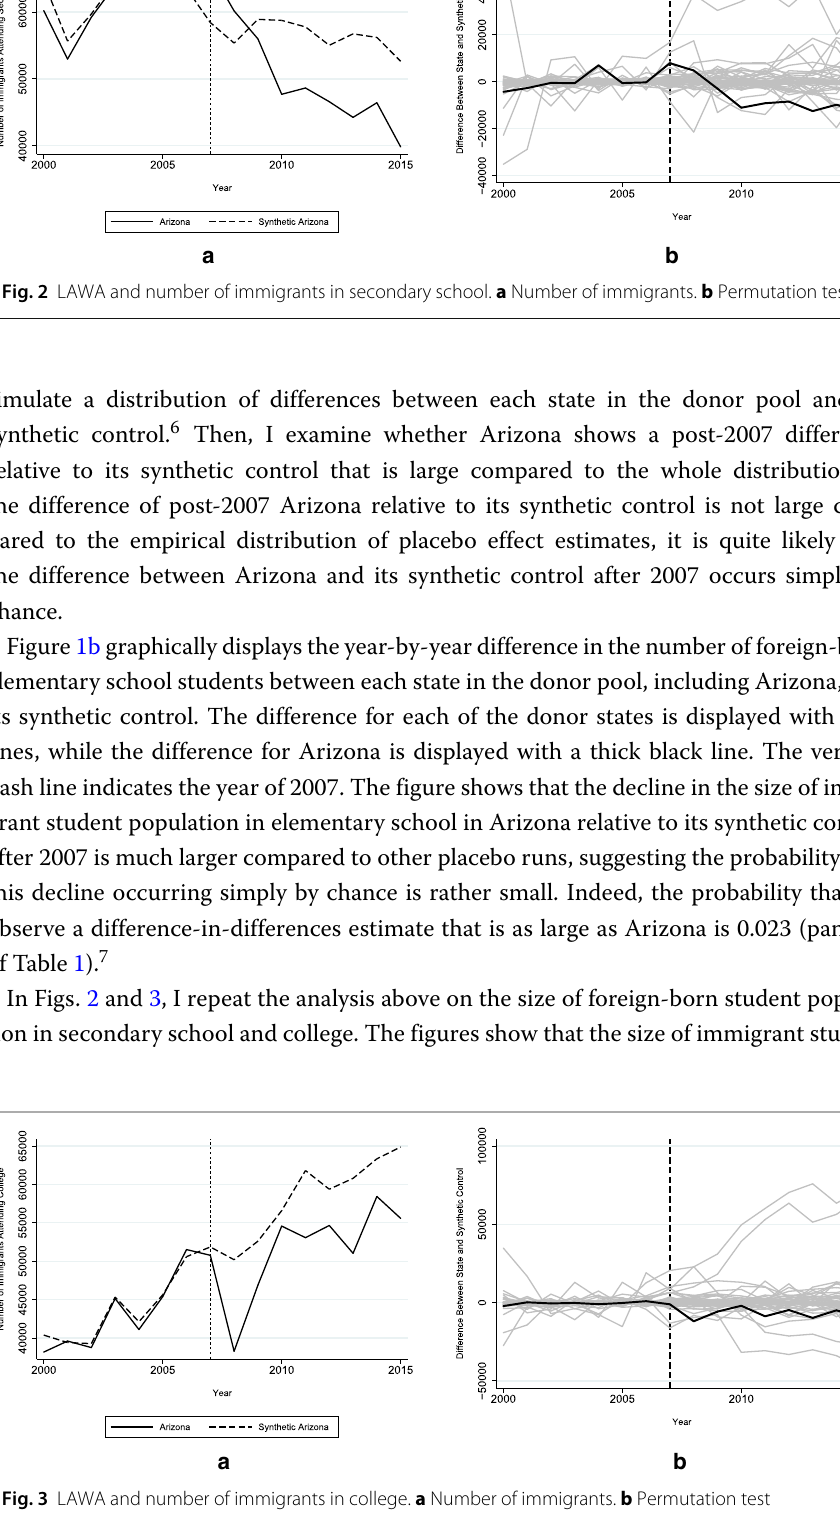
Fig. 2 LAWA and number of immigrants in secondary school. a Number of immigrants. b Permutation test